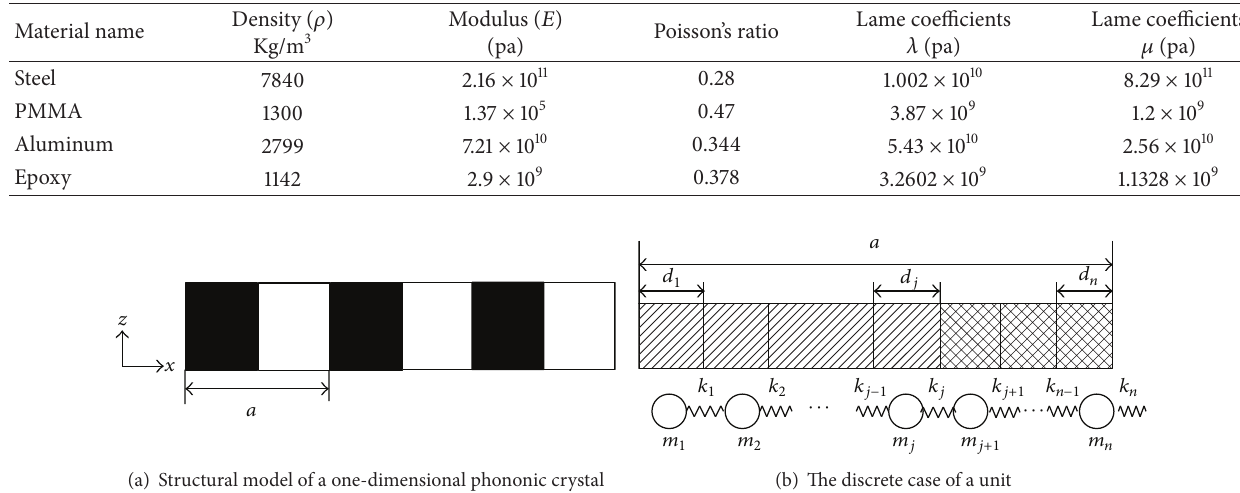
(b) The discrete case of a unit